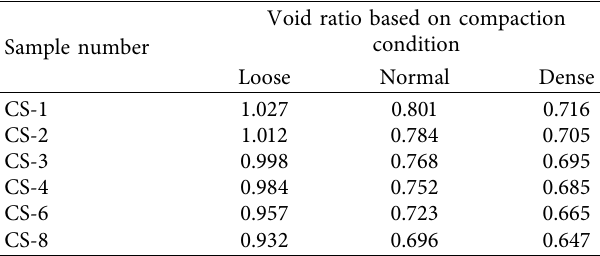
Table 4: Sample void ratios based on compaction